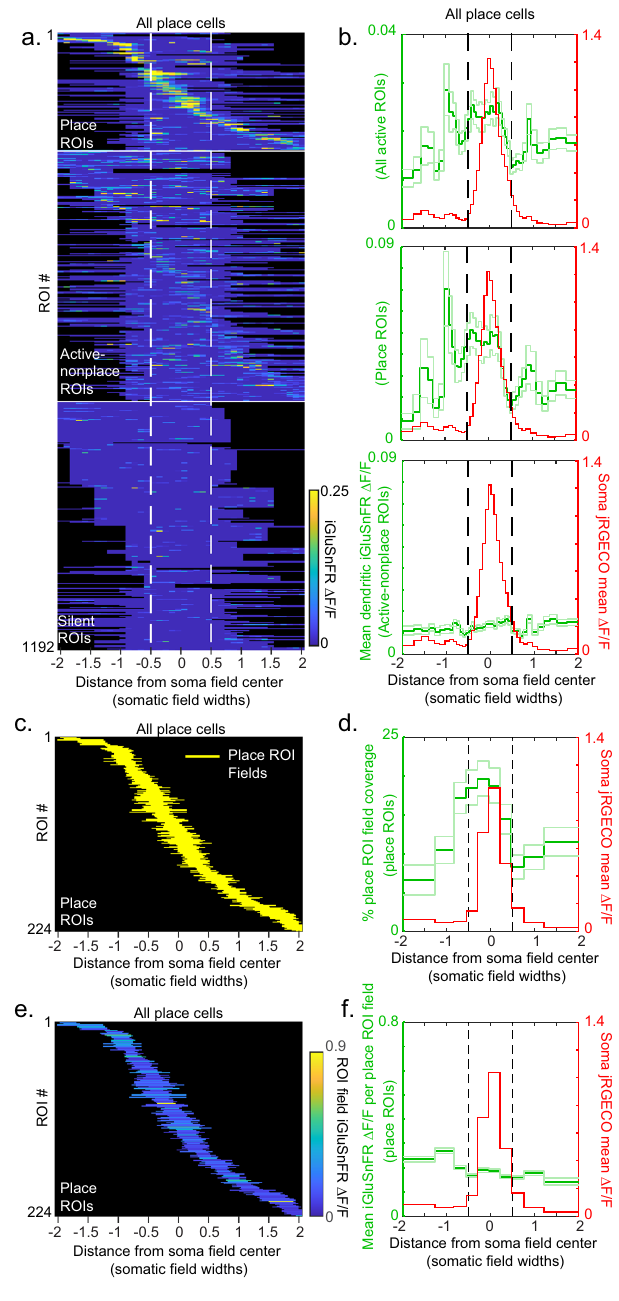
test) or versus inter-dendrite correlations (0.010 ± 0.0005, p = 2e − 16, rank-sum test). Temporal correlation versus intra-dendrite ROI distance analysis (Fig. 4c) revealed elevated correlations on the ~10 µm scale in place cells (larger than inter-dendrite correlations, p = 7e − 23, rank-sum test), with a slower correlation falloff in place cells versus nonplace cells (exponential fi ts, tau = 1.52 µm vs 1.14 µm, respectively) and no observable falloff for inter-dendrite ROI pairs (Fig. 4c). Further, a greater percentage of intra-dendrite ROIs within 10 µm of each other was likely to be co-active in place vs nonplace cells (Fig. S9d). Thus, excitatory input to place cell dendrites was functionally organized such that, on average, ROIs < ~10 µm apart encoded more similar track locations and were more likely to be co-active in time compared to ROIs at greater dendritic distances apart.